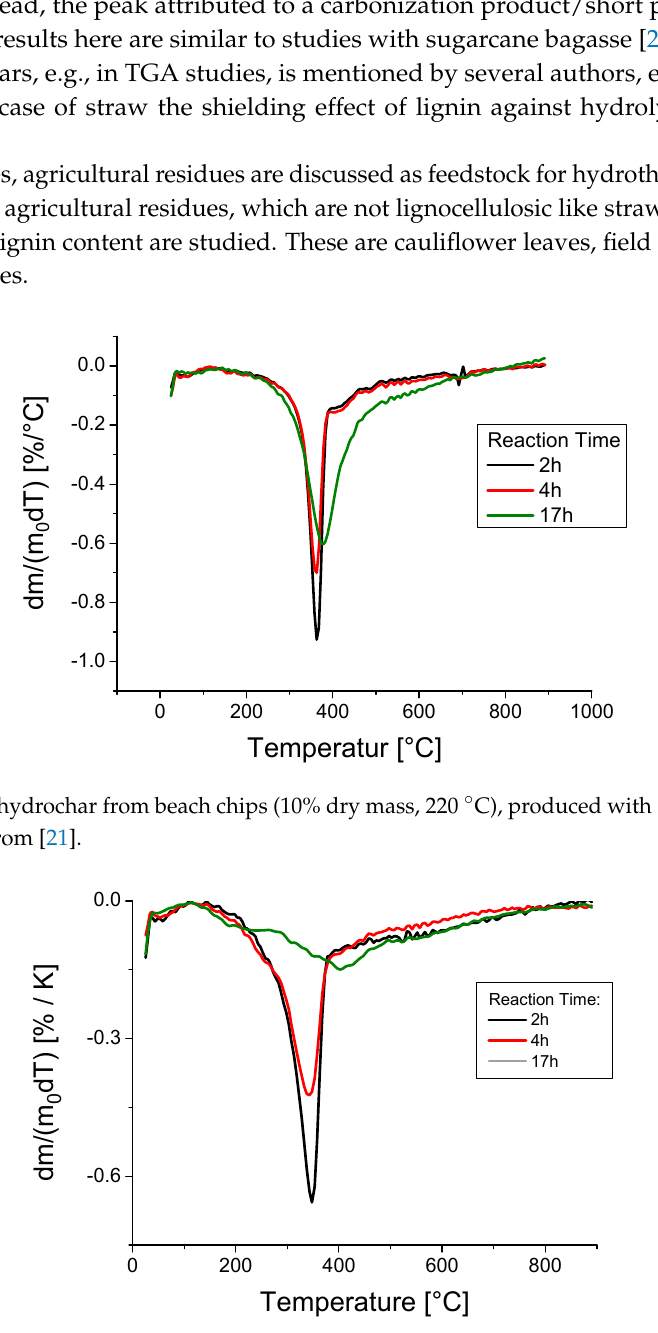
Figure 6. DTG of hydrochar from straw (10% dry mass, 220 °C), produced with different reaction times, modified from [21].